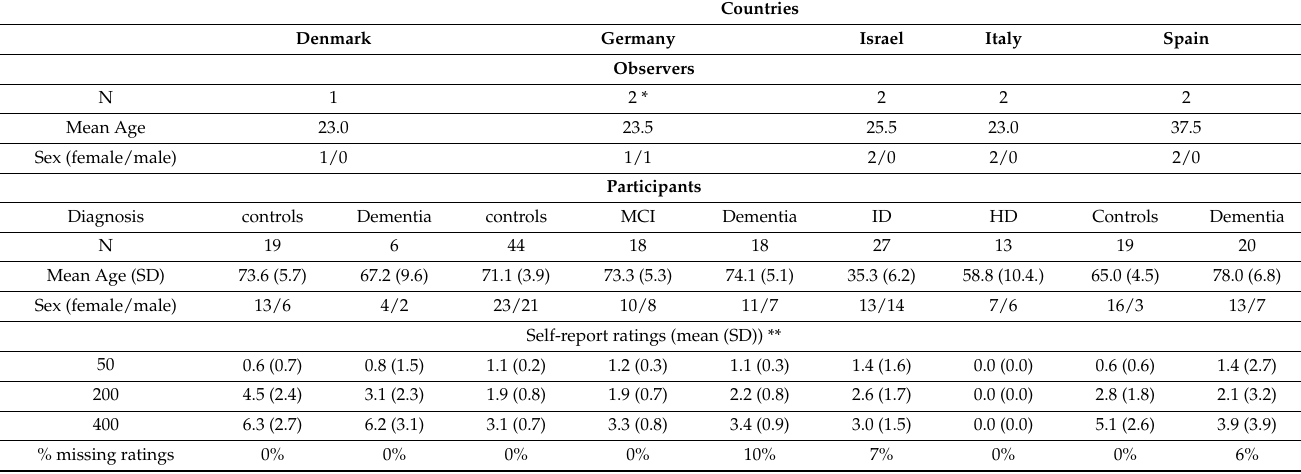
Table 1. Demographic data of the observers as well as of the